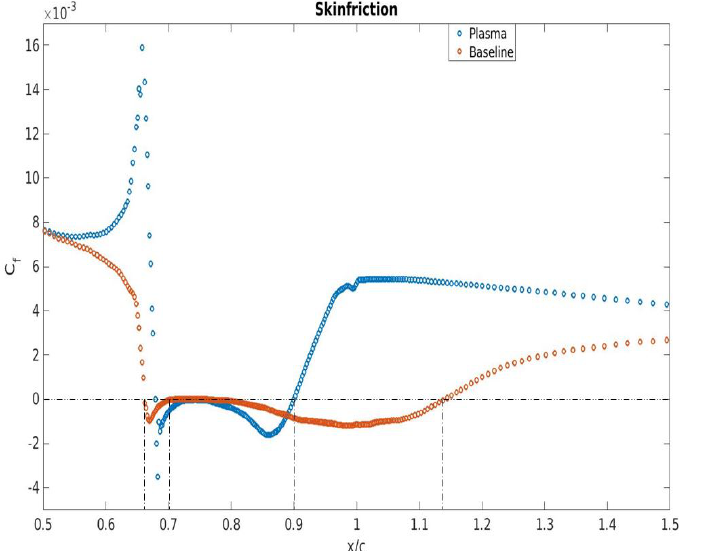
Figure 15. Skin friction coefficient comparison between the baseline and plasma case.